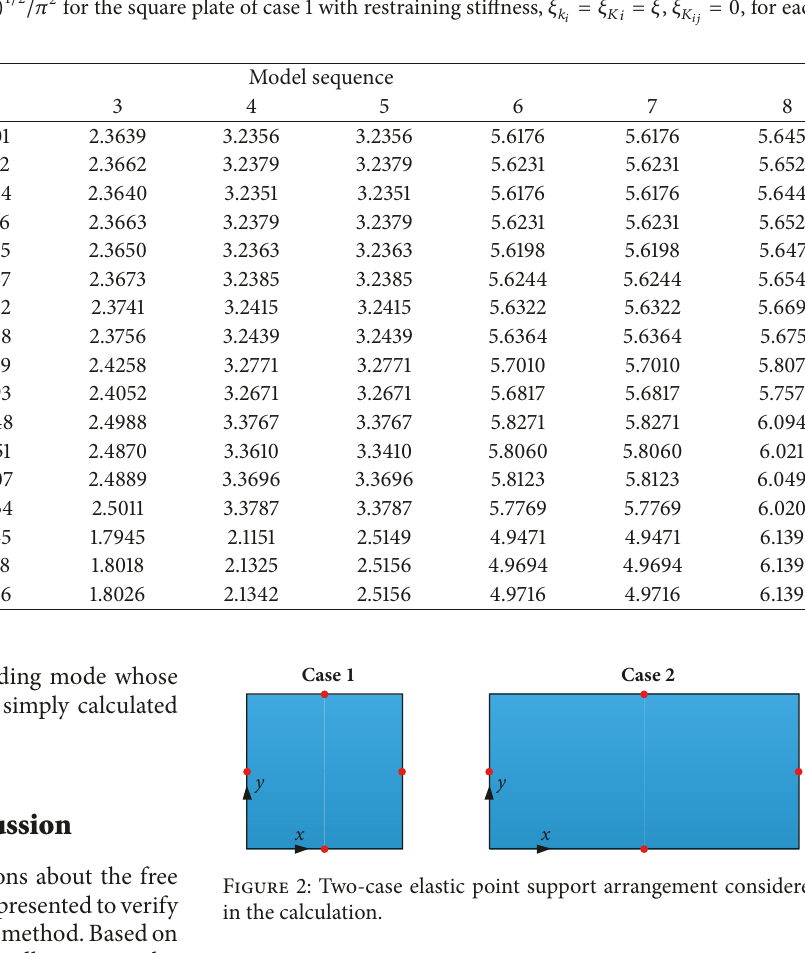
= 𝜉 = 𝜉 , 𝜉 = 0 , for each 𝐾𝑖 𝐾 𝑖𝑗 𝑖